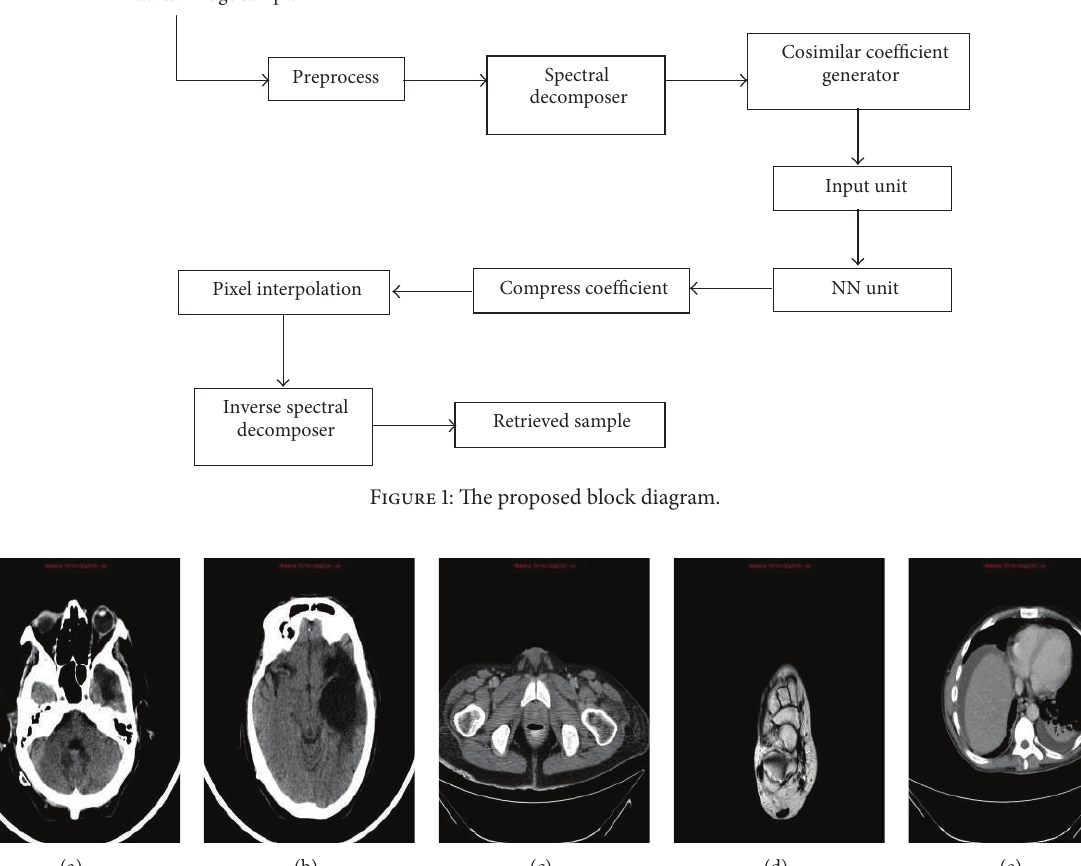
Step 7. Now the matrix format (𝐼) is converted into the image file